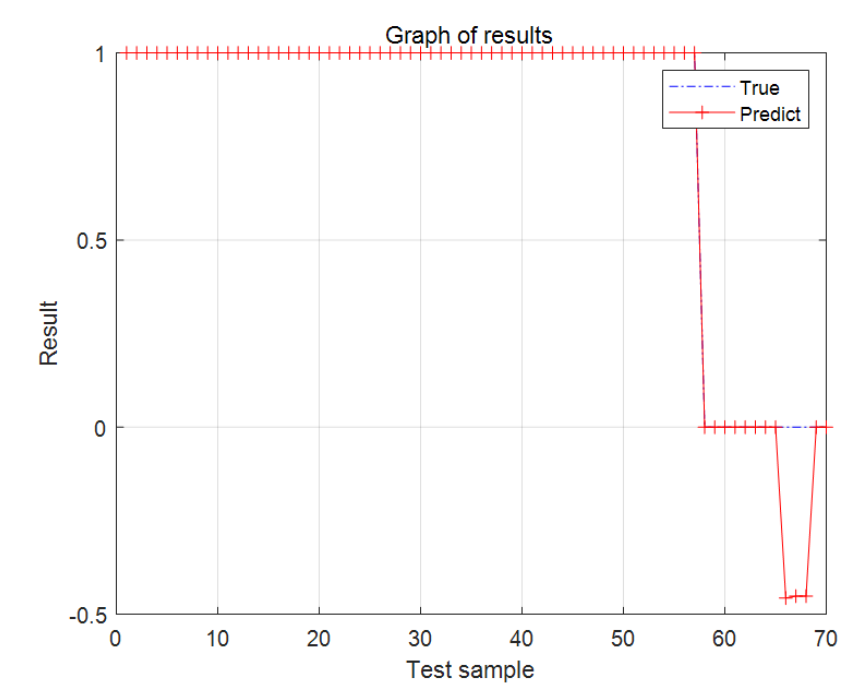
Figure 8. Plot of BPNN model fits after process.